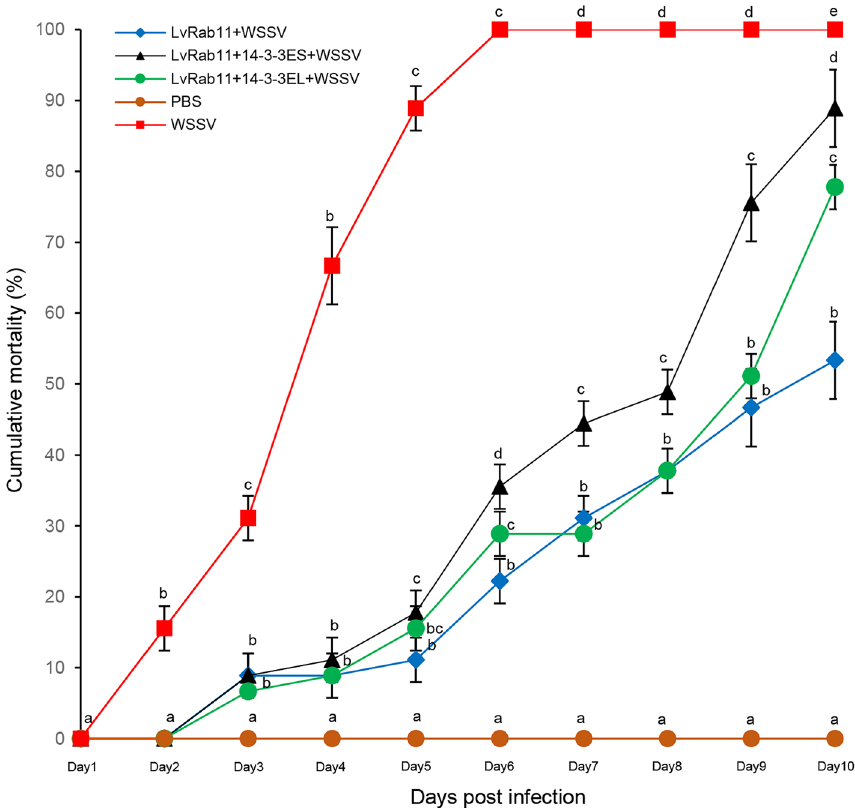
Figure 7. Cumulative post challenge shrimp mortality. The solutions used for shrimp injection are shown on the left. Cumulative mortality data represent the pooled results for 3 replications (n = 15 for each group). Error bars indicate standard deviations. Different letters indicate statistically significant difference between five groups ( p <